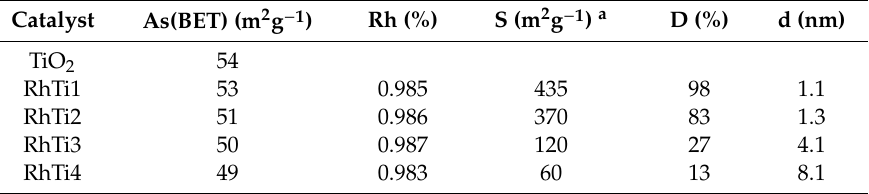
Table 1. Net percentage, surface area, dispersion and metal particle size for each